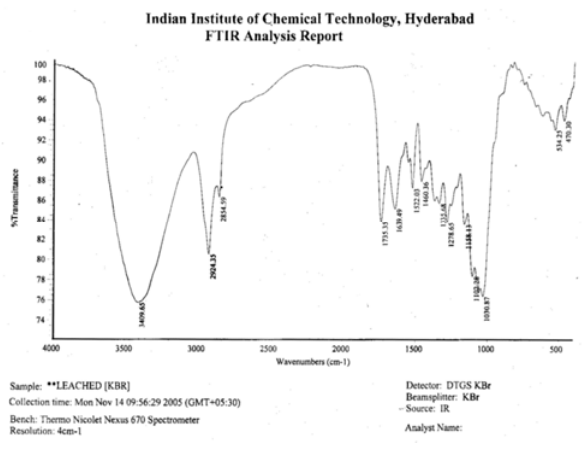
Figure 14: FT-IR Spectra of LBM of Calotropis procera Application of Biomass for Removal of Nickel from